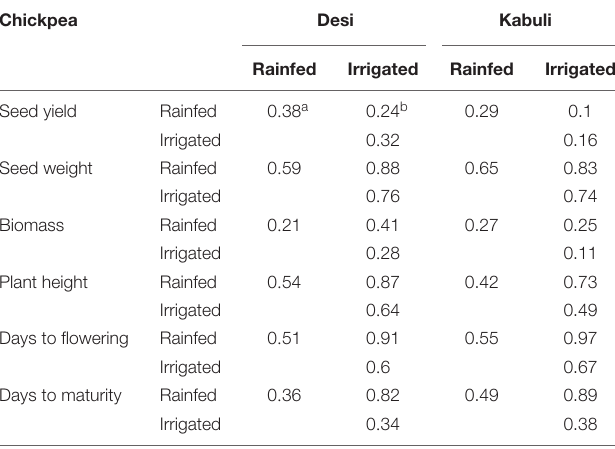
TABLE 2a | Plot level heritabilities and genetic correlations across rainfed and irrigated environments for chickpea. Chickpea